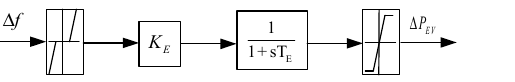
Figure 3. Primary electric vehicle frequency regulation control model.